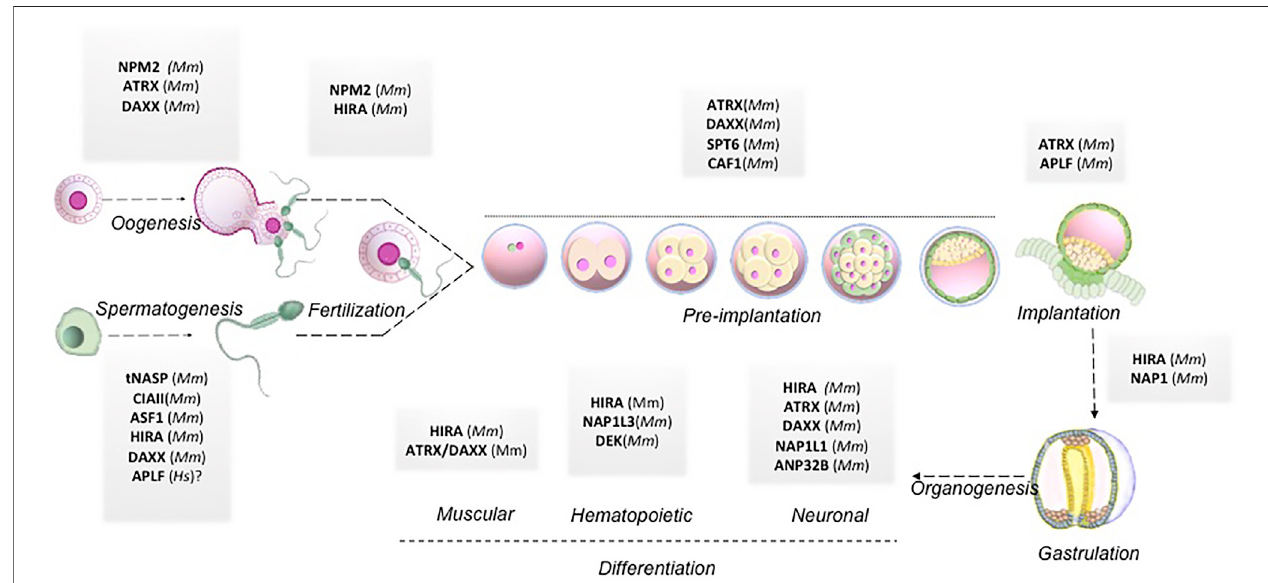
FIGURE4| Histonechaperonesinmammalianembryodevelopment.Schematicrepresentationoffunctionalimplicationofdifferenthistonechaperonesinvolvedin different stages of embryo development right from gametogenesis to organogenesis. Abbreviations: Mm, Mus musculus ; Hs, Homo sapiens.